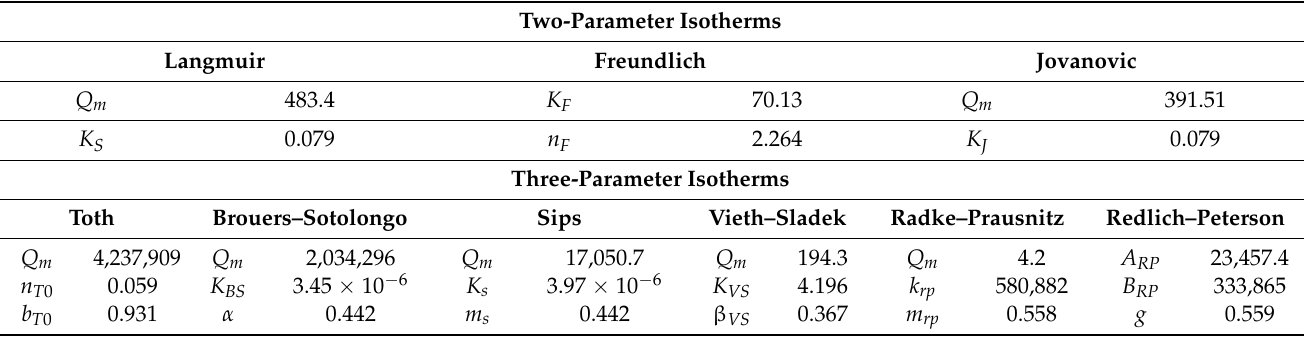
Table 4. Calculated parameters of adsorption